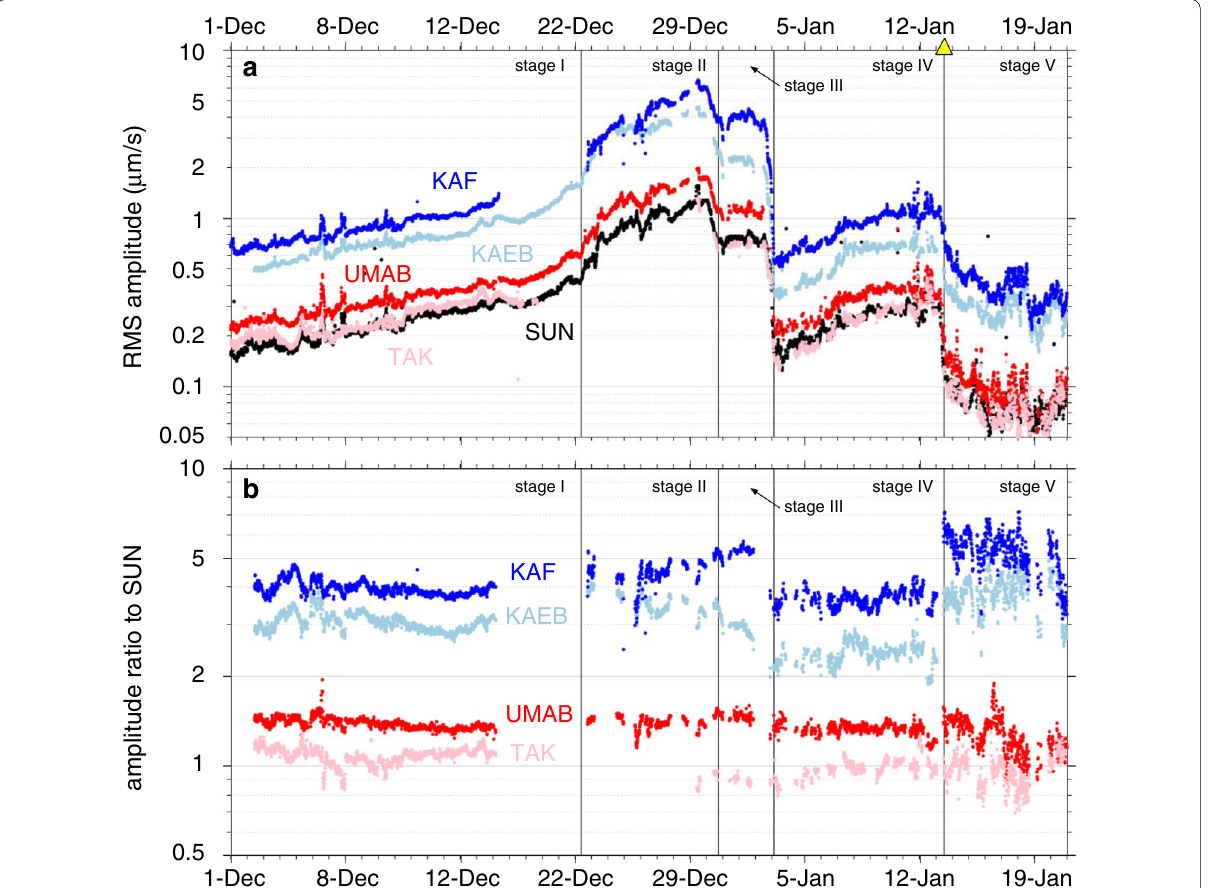
Fig. 6 Observed root-mean-squared amplitude and amplitude ratio. a Time evolution of root-mean-squared amplitude recorded at all stations (frequency: 5–10 Hz; window length: 30 min with a sliding length of 15 min). The yellow triangle represents the reported eruption (Japan Meteorological Agency 2014). The boundaries of the five stages defined in the present study are shown as vertical lines. b Examples of amplitude ratios at each station (in this case, referenced to SUN)